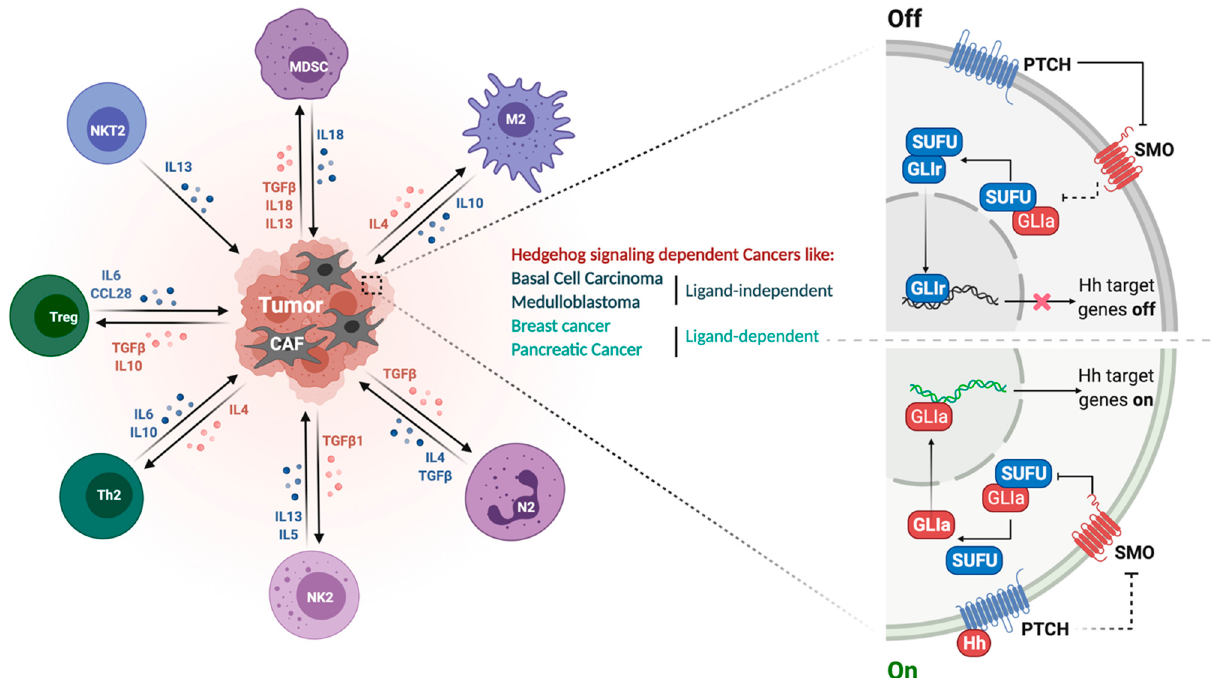
Figure 1. SHH signaling pathway and its immunosuppressive tumor microenvironment. Right panel represents the ON-OFF signaling of the HH pathway. In the absence of HH ligand, Ptch1 inhibits surface localization of Smo, leaving Sufu free to bind to Gli, thus repressing it and preventing HH target gene expression. In the presence of HH ligand, Gli is released from Sufu to translocate into the nucleus, thus activating HH target genes. Left panel elaborates different immunosuppressive cell types infiltrated into the tumor microenvironment and the associated cytokines and growth factors. Oncogenic HH signaling recruits immune cells such as tumor-associated macrophages (TAMs), immune-suppressive myeloid-derived suppressor cells (MDSCs) for immune modulation.